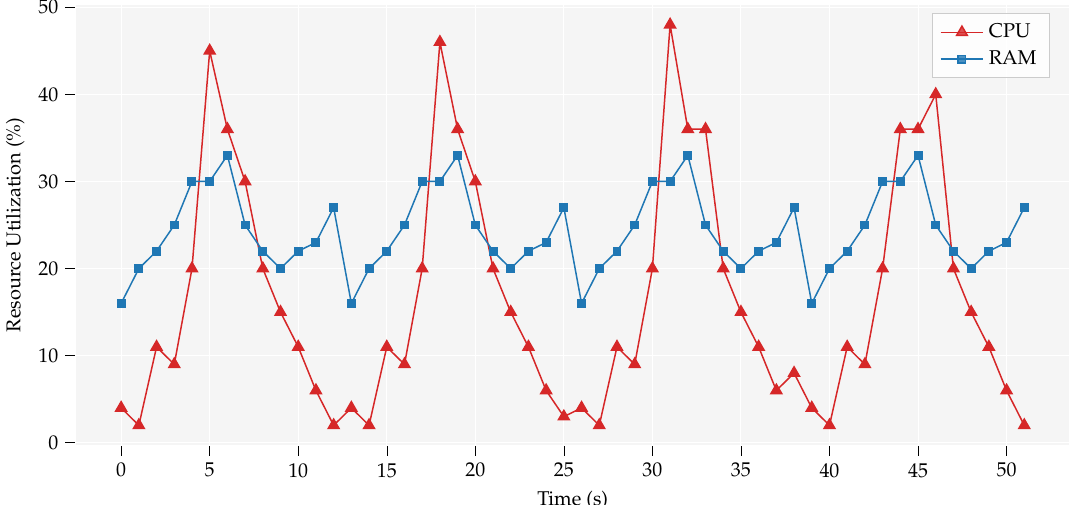
Figure 4. Consumption of CPU and RAM during randomly selected transactions and idle time in between. During transaction handling, CPU requires more resources while in the idle condition it’s quite low. For the RAM, it is not a huge difference during the transaction